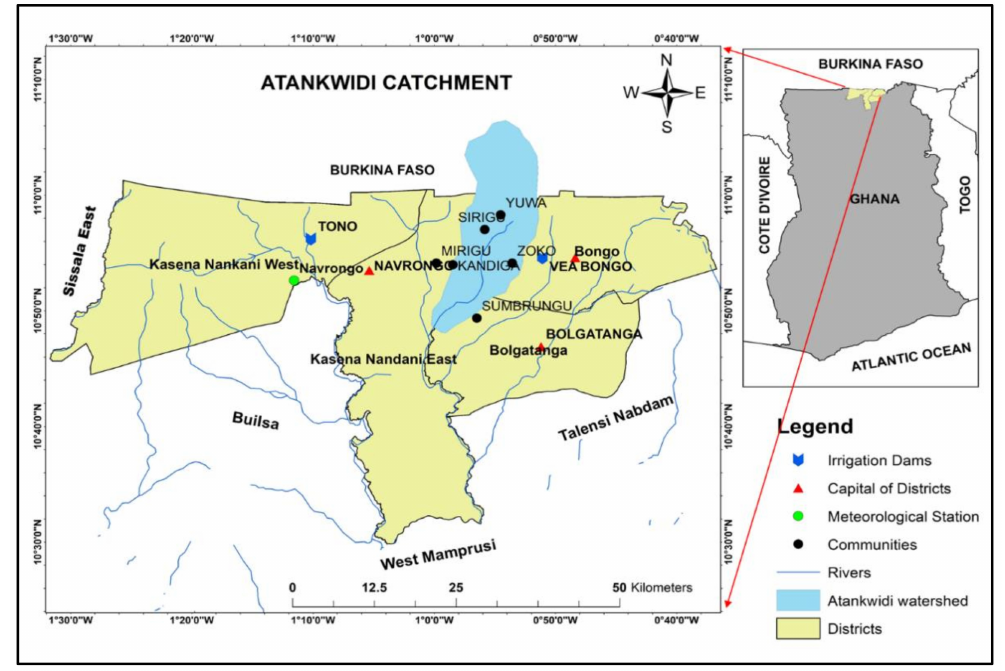
Figure 2. Atankwidi catchment.